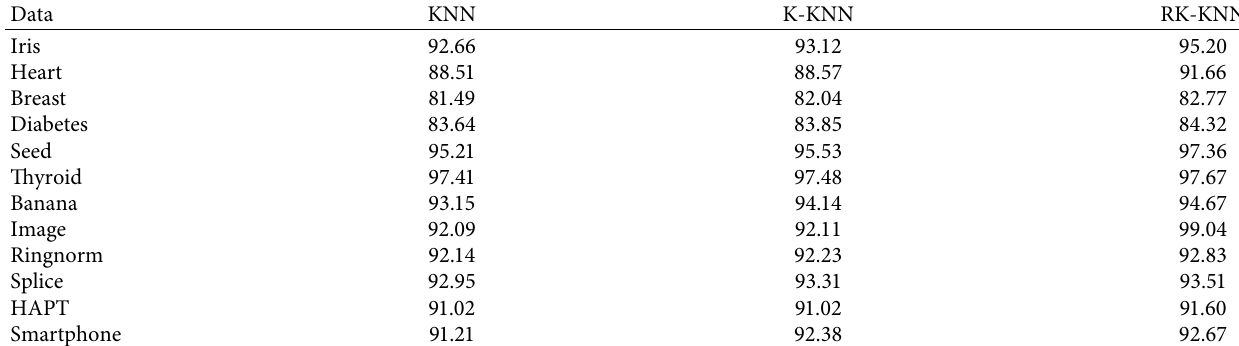
Table 3: The data of Friedman